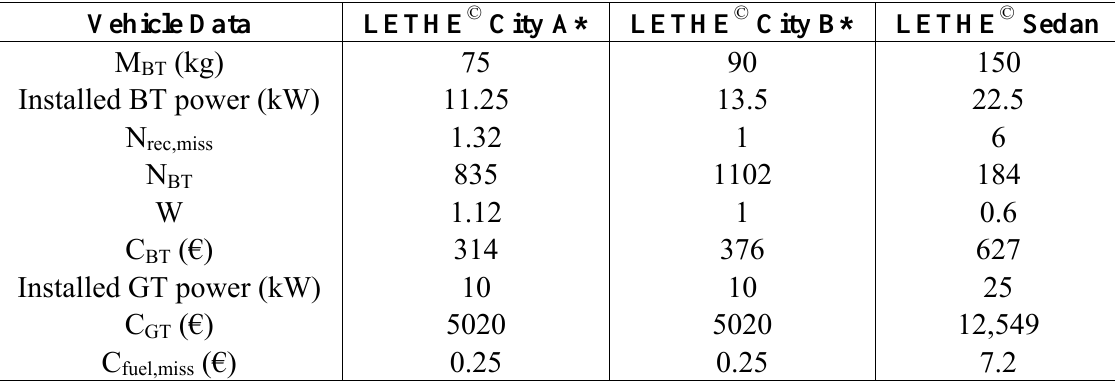
Table 11. Installation costs for battery